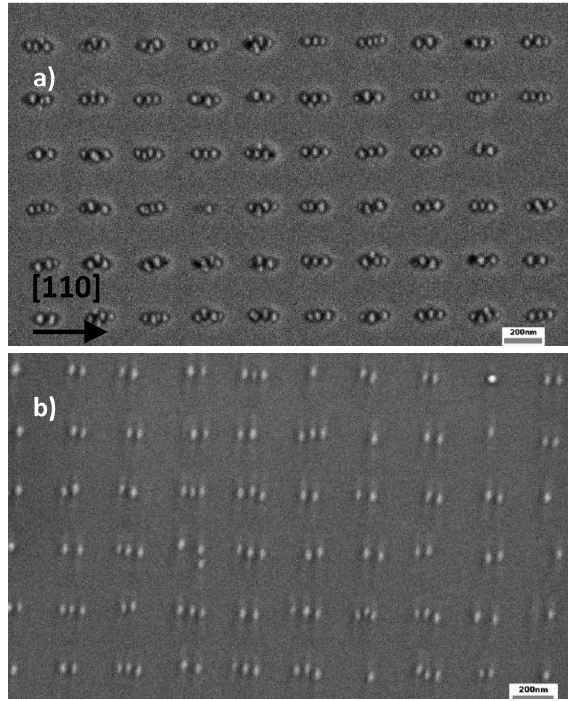
Figure 6. Cont . Figure 6.